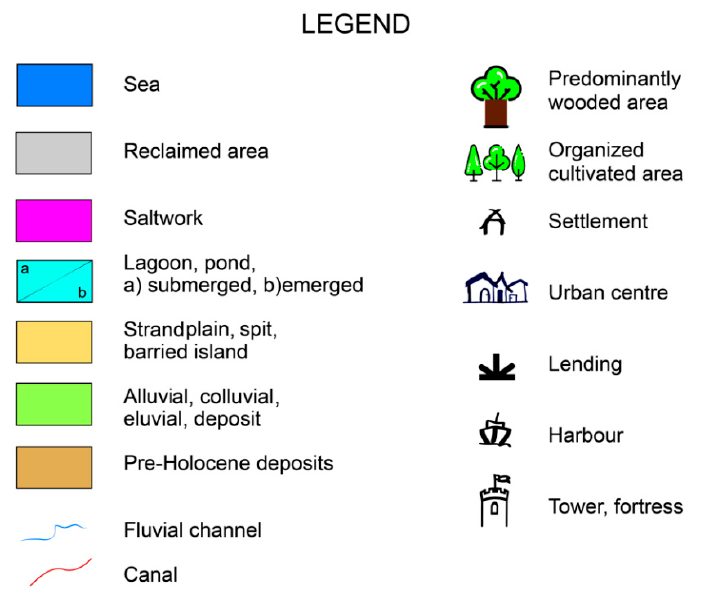
Figure 5. Legend for Figures 4, 8 and 11.